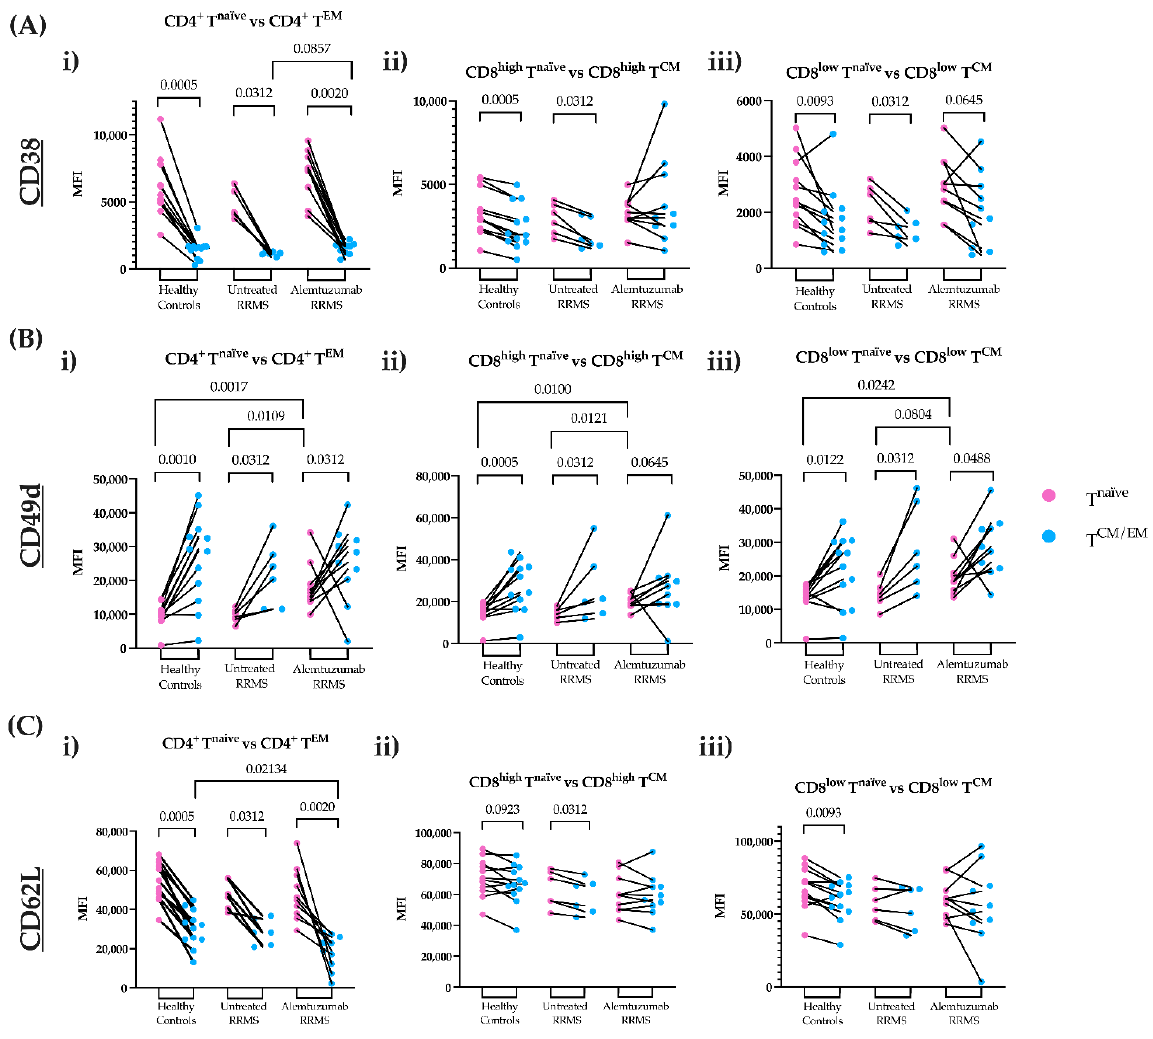
Figure 2. The mean fluorescence intensity (MFI) of CD38, CD49d and CD62L on fresh CD4 + T EM and CD8 + T CM cells compared to their naïve phenotypes. The expression of cell surface markers was calculated in healthy controls (n = 12), untreated RRMS (n = 6) and alemtuzumab-treated RRMS patients (n = 10) for naïve (pink) and memory (blue) T cells. ( A ) CD38 expression on ( i ) CD4 + T EM cells versus CD4 + T naïve cells ( ii ) CD8 high T CM cells versus CD8 high T naïve cells ( iii ) CD8 low T CM cells versus CD8 low T naïve cells. ( B ) CD49d expression on ( i ) CD4 + T EM cells versus CD4 + T naïve cells ( ii ) CD8 high T CM cells versus CD8 high T naïve cells ( iii ) CD8 low T CM cells versus CD8 low T naïve cells. ( C ) CD62L expression on ( i ) CD4 + T EM cells versus CD4 + T naïve cells ( ii ) CD8 high T CM cells versus CD8 high T naïve cells ( iii ) CD8 low T CM cells versus CD8 low T naïve cells. Wilcoxon matched-paired signed-rank test compared paired naïve and memory T cells. A Kruskal–Wallis with Dunn’s multiple comparisons test was done to compare between groups. p ≤ 0.1 are shown. RRMS, relapsing-remitting multiple sclerosis; T CM , central memory T cells; T EM , effector memory T cells; T naïve , naïve T cells.